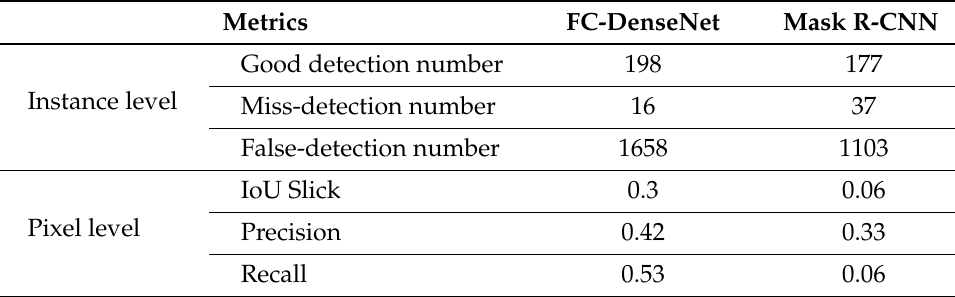
Table 5. Results of FC-DenseNet versus Mask R-CNN on a test set of 214